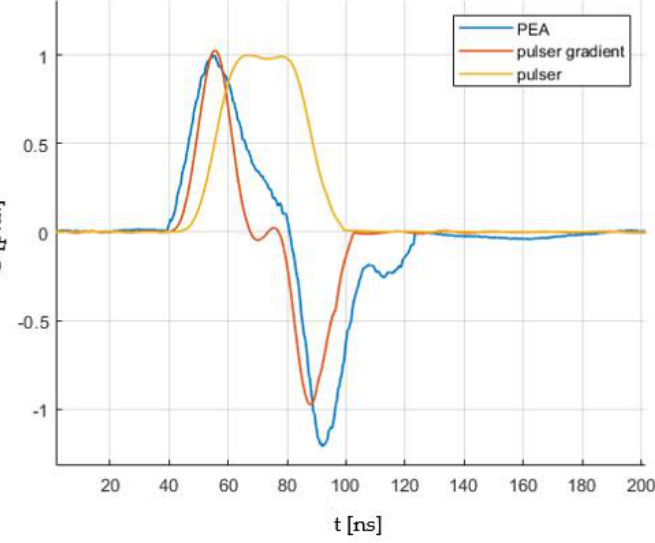
Figure 10. Comparison between raw pulser signal t w = 40 ns, its gradient, and PEA signal measured for this pulser.